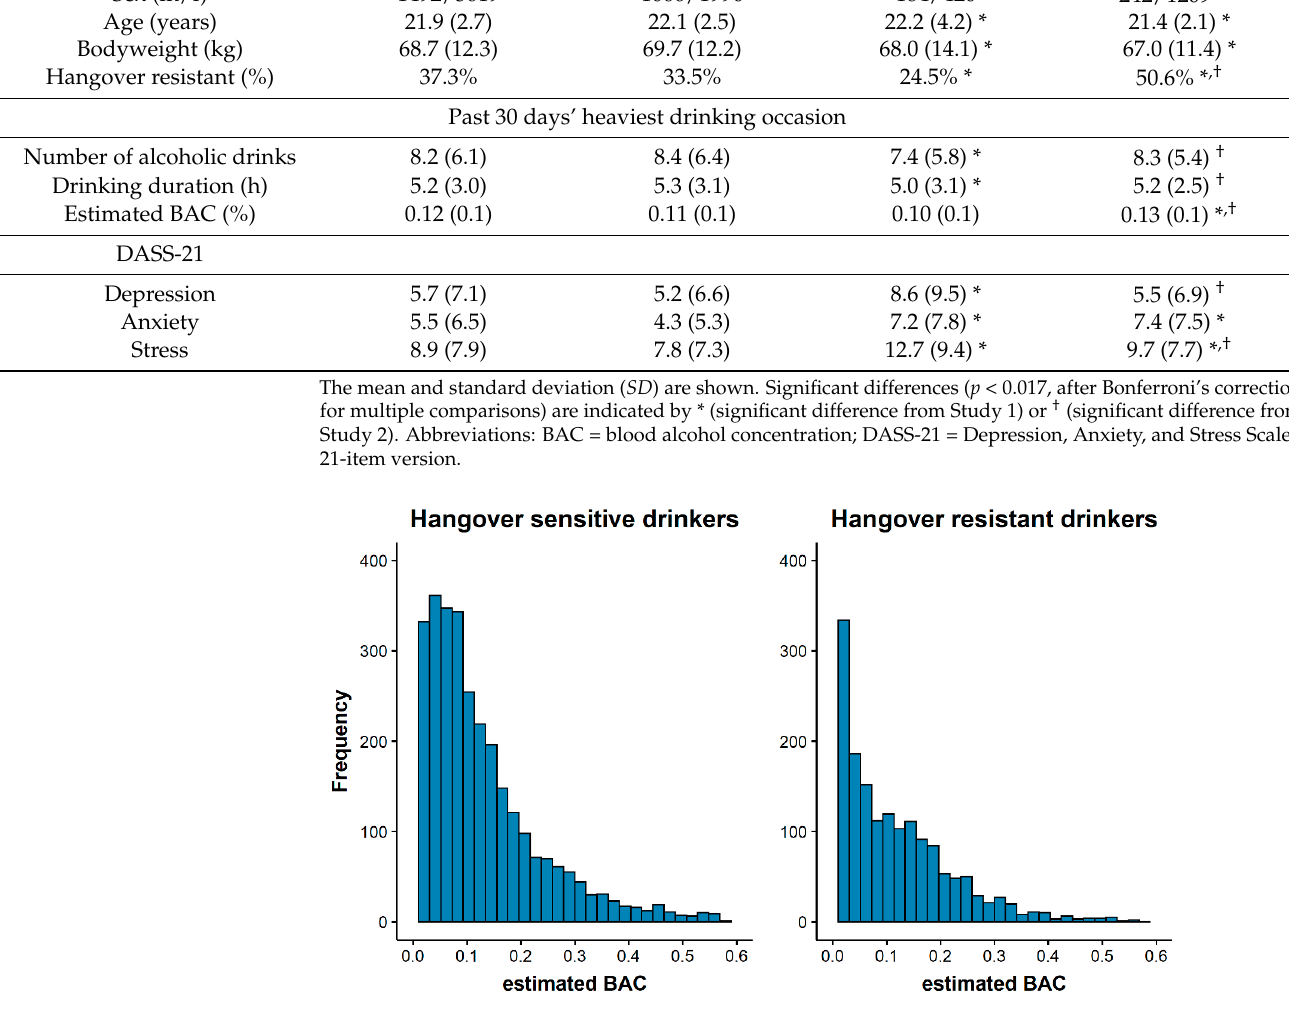
Table 1. Demographics and study outcomes.